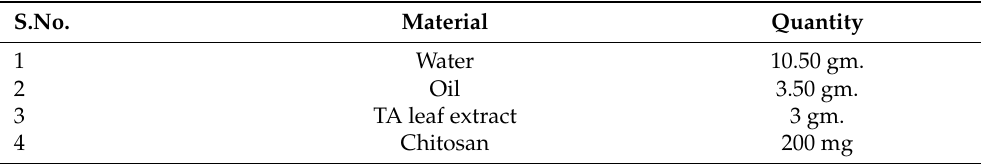
Table 1. Material and their Quantity used in nanoemulsion.